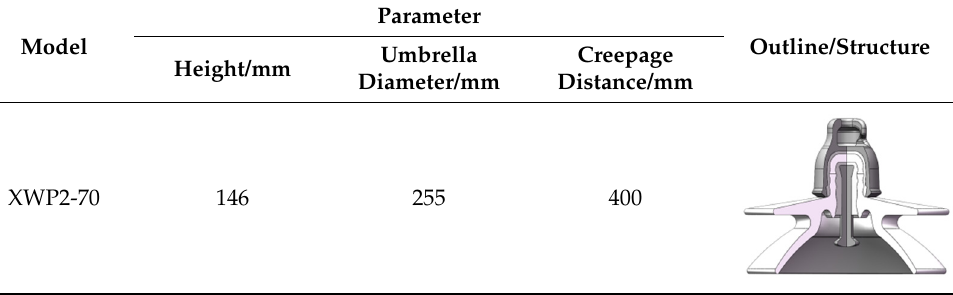
Table 1. Structure parameters of insulator. Model